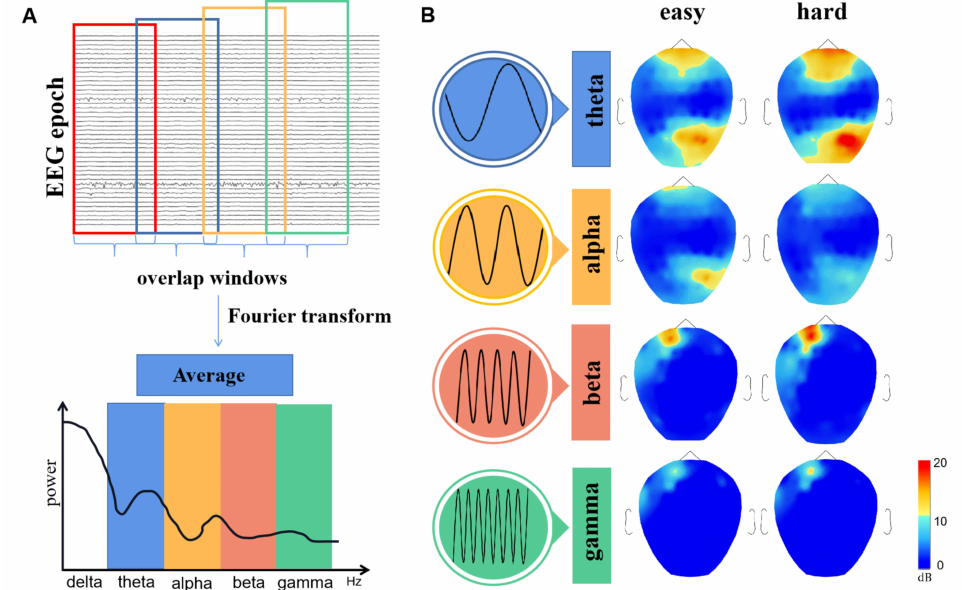
Figure 3. The PSD topographies of four frequency bands in easy task and hard task states. ( A ) Calculating the PSD with the Welch method and the performance of spectral estimation is improved by overlap window method. ( B ) The PSD topographies in easy task and hard task states, the average power is drawn at each frequency band. The alpha power change is mainly located at the posterior area of the brain, especially at the right hemisphere ( p = 0.067). Comparing with the easy task state, the power amplitude of beta in the working state at the left prefrontal area improved significantly (paired-samples test: p = 0.01 < 0.05). The theta band power amplitude improved at the prefrontal and right posterior area in both easy and hard states, and a more significant rise of amplitude is found in hard